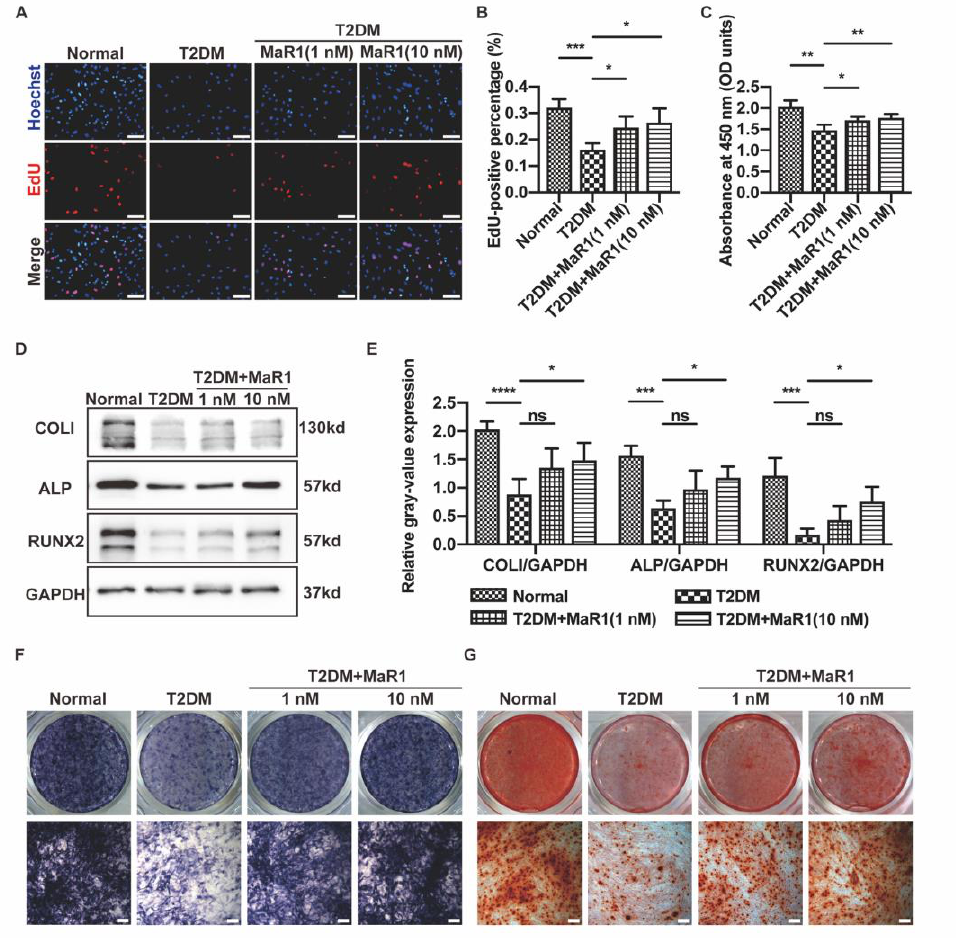
Figure 1. MaR1 improved the proliferation and osteogenic capability of osteoblasts in T2DM conditions. ( A ) To assess the osteoblasts performing DNA replication, EdU staining was tested. EdU-positive nuclei (red) and all nuclei (blue) . Scale bar = 100 μm. ( B ) The quantitative study of cells using EdU staining. ( C ) At the end of the second day of incubation, the Cell Counting Kit-8 assay was conducted. ( D ) After seven days of osteogenic induction, Western blot analysis was used to evaluate the protein levels of COLI, ALP, and RUNX2. ( E ) The study of the Western blot analysis quantification of gray-value expression. ( F ) ALP staining following a week of osteogenic induction Scale bar = 200 μm. ( G ) ARS staining following a 14-day osteogenic induction. Scale bar = 200 μm. Data are presented as means ± SDs from three separate experiments (n = 3). ns p > 0.05; * p < 0.05; ** p < 0.01; *** p < 0.001; **** p < 0.0001.